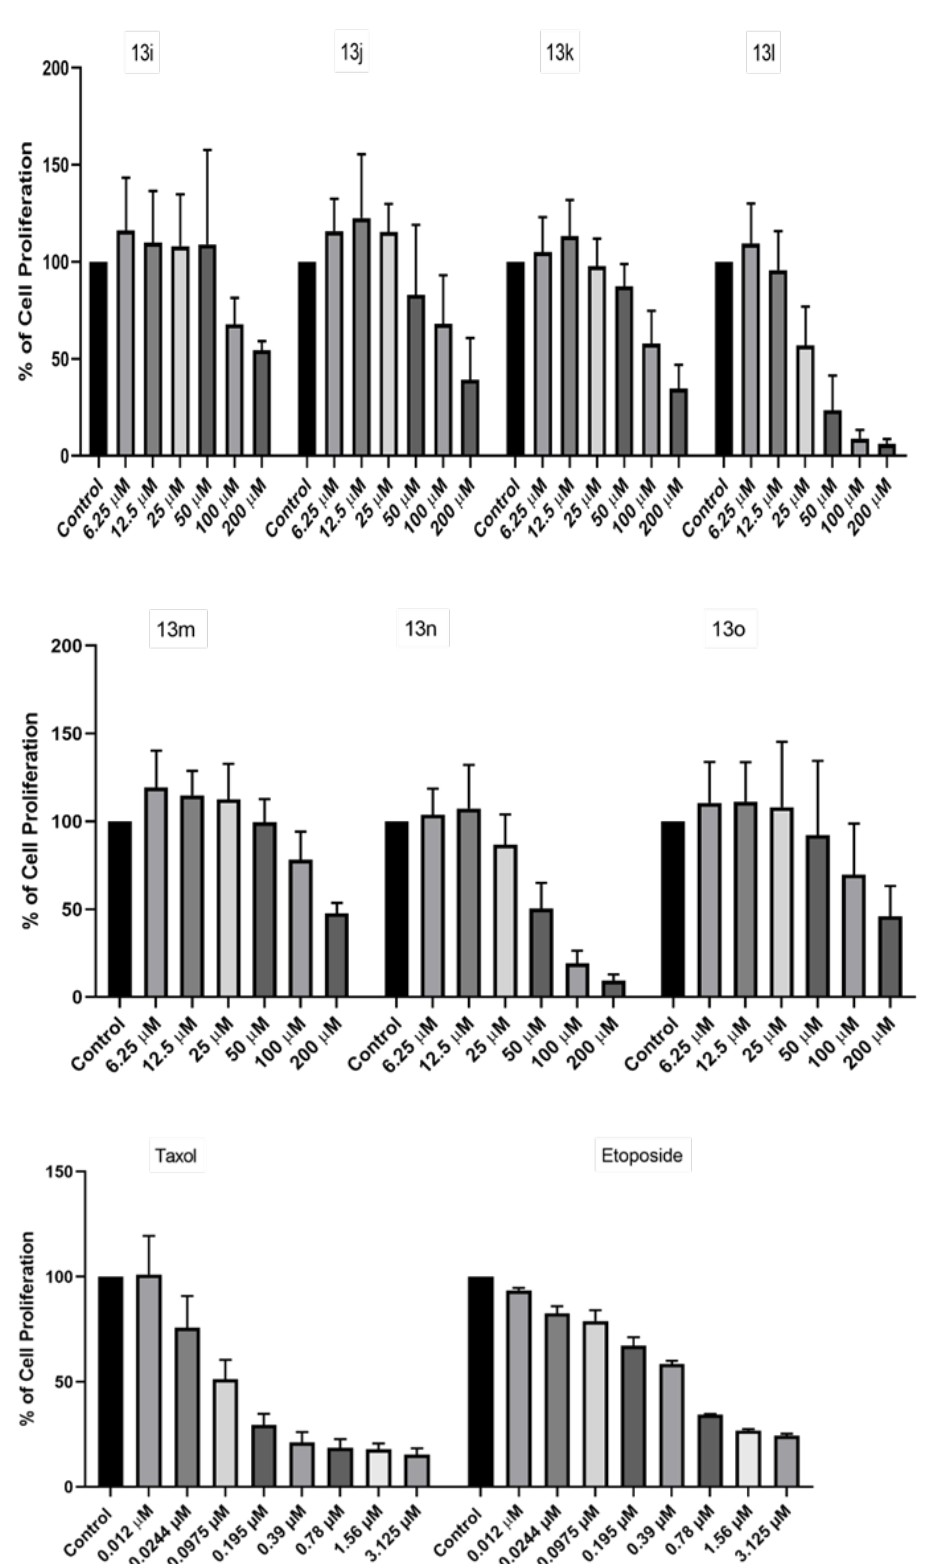
Figure 2. Differential effect of the compounds 13a–o in the proliferation of MCF-7 cell line. MCF-7 cells were treated with increased doses of compounds 13a to 13o and Taxol and Etoposide were used to compare the effect. Control cells are cells not treated.